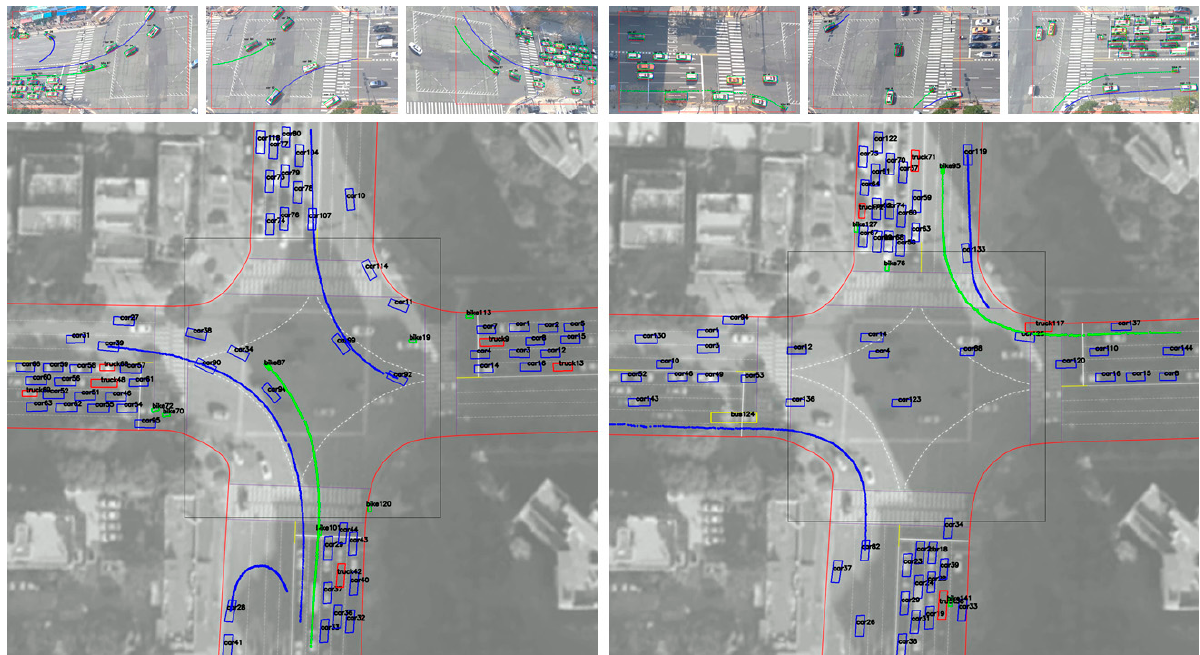
Figure 14. Examples of vehicle trajectories: left turn and U turn ( left ); right turn ( right ). As shown in Figures 13 and 14, the color of the vehicle (bike: green, car: blue, bus: yellow, truck: red, concrete mixer: purple) is displayed differently depending on the type.